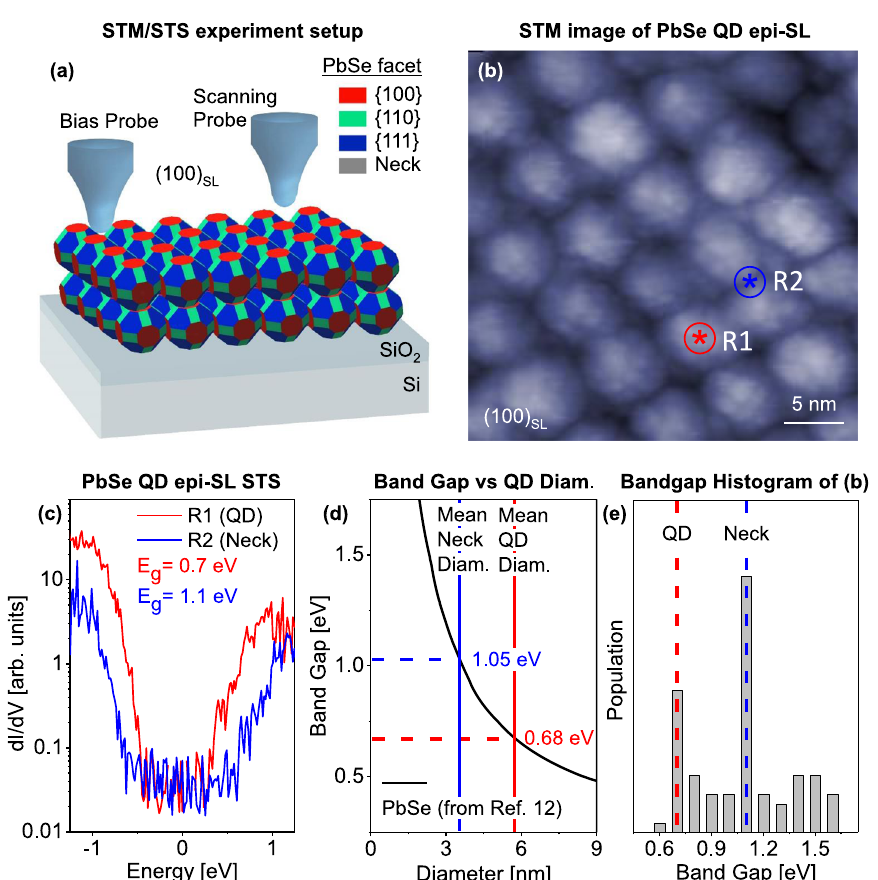
c Representative d I /d V spectra acquired from the QD center (red circle in b ) and neck (blue circlein b ) adjoining two QDs. Bandgaps of0.7eV for the QDand 1.1eV for the neck were extracted from the spectra. d Dependence of QD bandgap on diameter from ref. 12. e Histogram of the bandgap values obtained from 81 STS locations in b . The histogram shows peaks at 0.7eV and 1.1eV, which are hypo- thesized to correspond to the expected bandgaps of the QDs and necks,